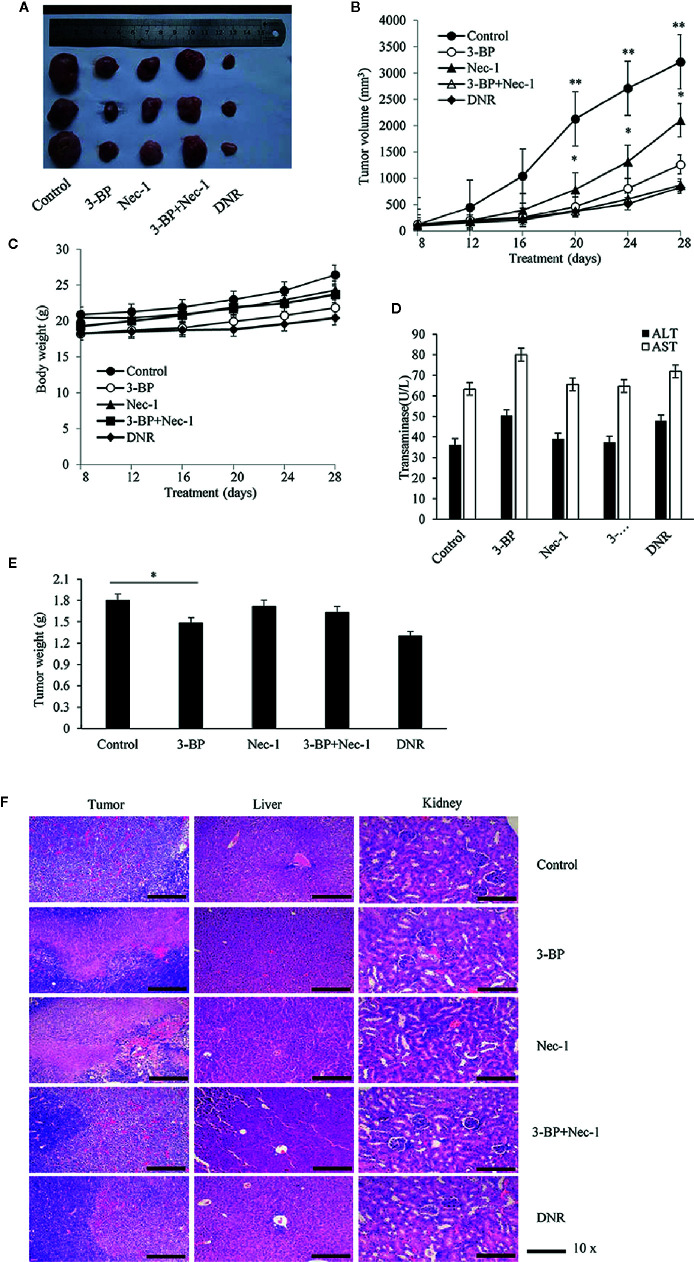
Anti-tumor effect of 3-BP in vivo. (A, B) Comparison of the transplanted tumor volume. (C, D) Bodyweight and tumor weight were monitored every 4 days and calculated using the formula: length x width2/2. (E) ALT and AST level in mice blood after 3-BP treatment. (F) H&E staining in vivo. *P < 0.05, **P < 0.01.